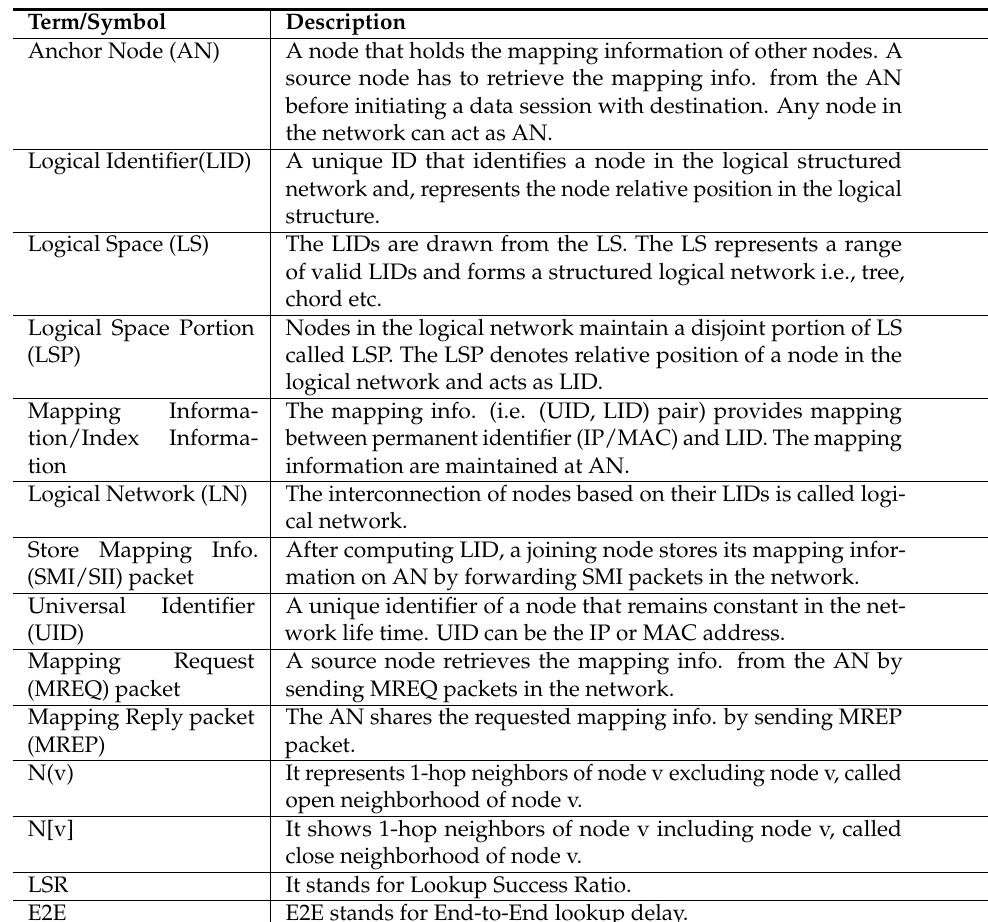
Table 1. Definitions/Abbreviations used in DHT